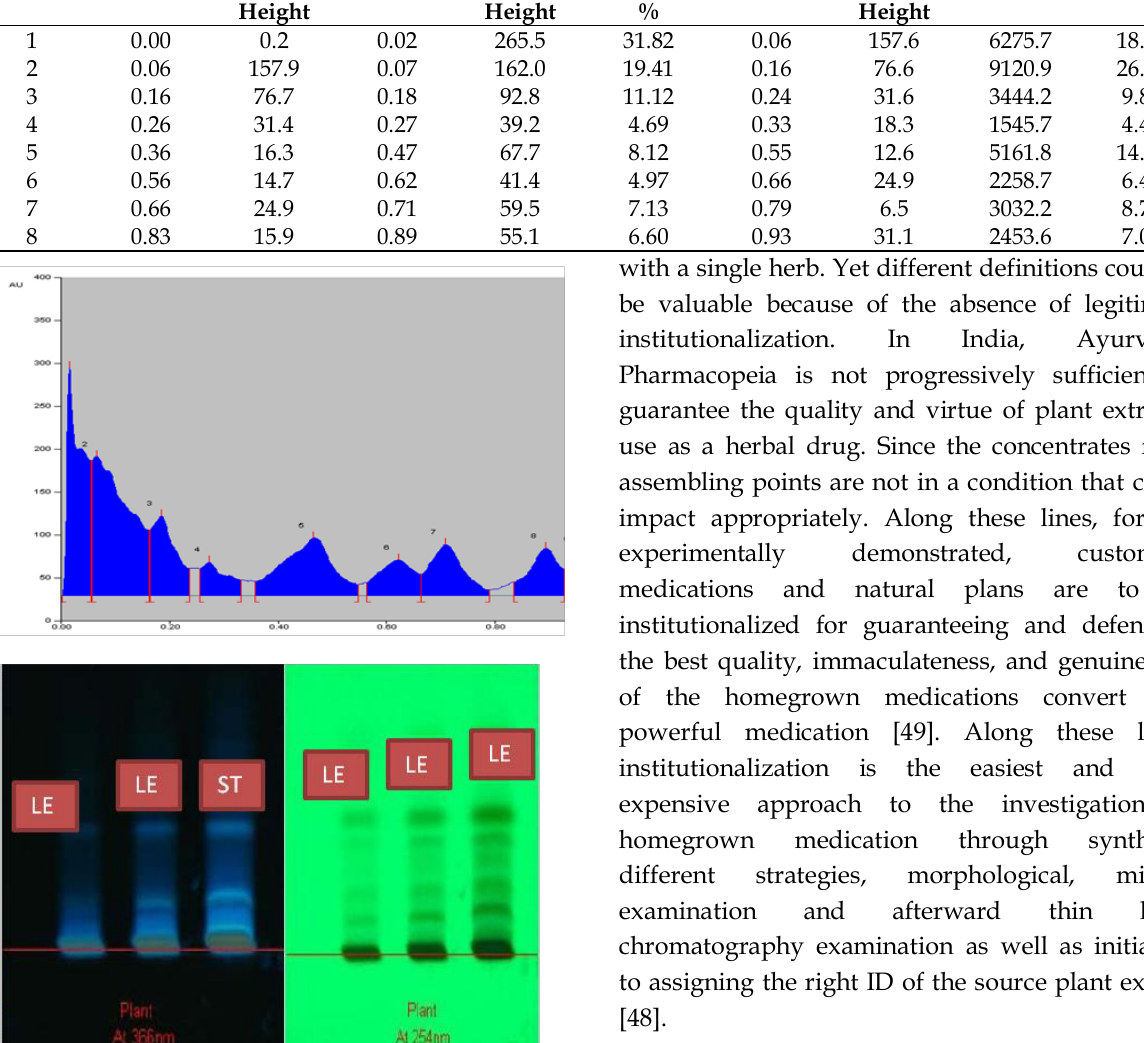
Table 11: R f value, No. of Peaks, peak area and height of hydroalcholic extract of R. indica in Toluene: Ethyl acetate at 254nm Peak